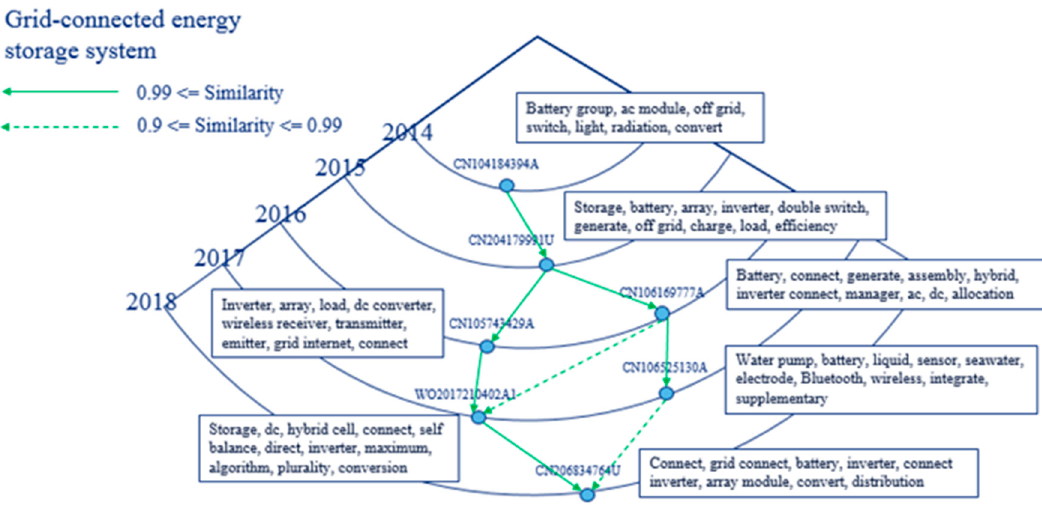
Figure 13. The key terms of the evolving patents in the grid-connected energy storage technology cluster.